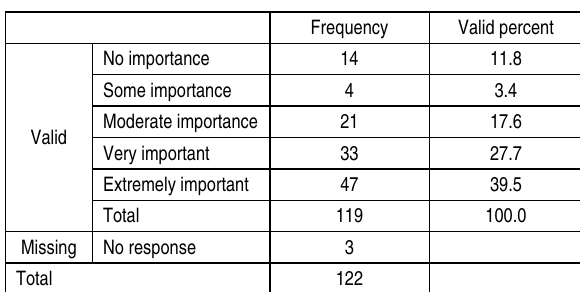
Table 12. Difficult to acquire a business